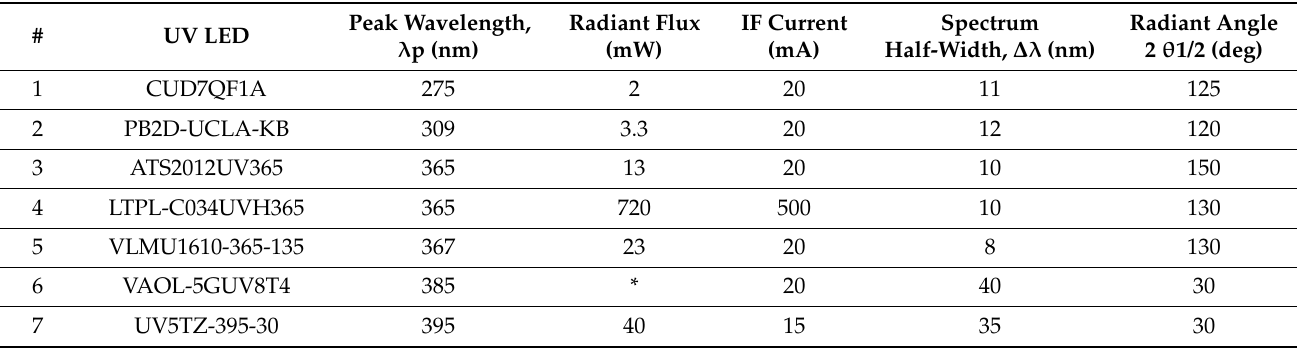
Table 2. Electro-optical parameters of the UV LEDs used in the calibrator